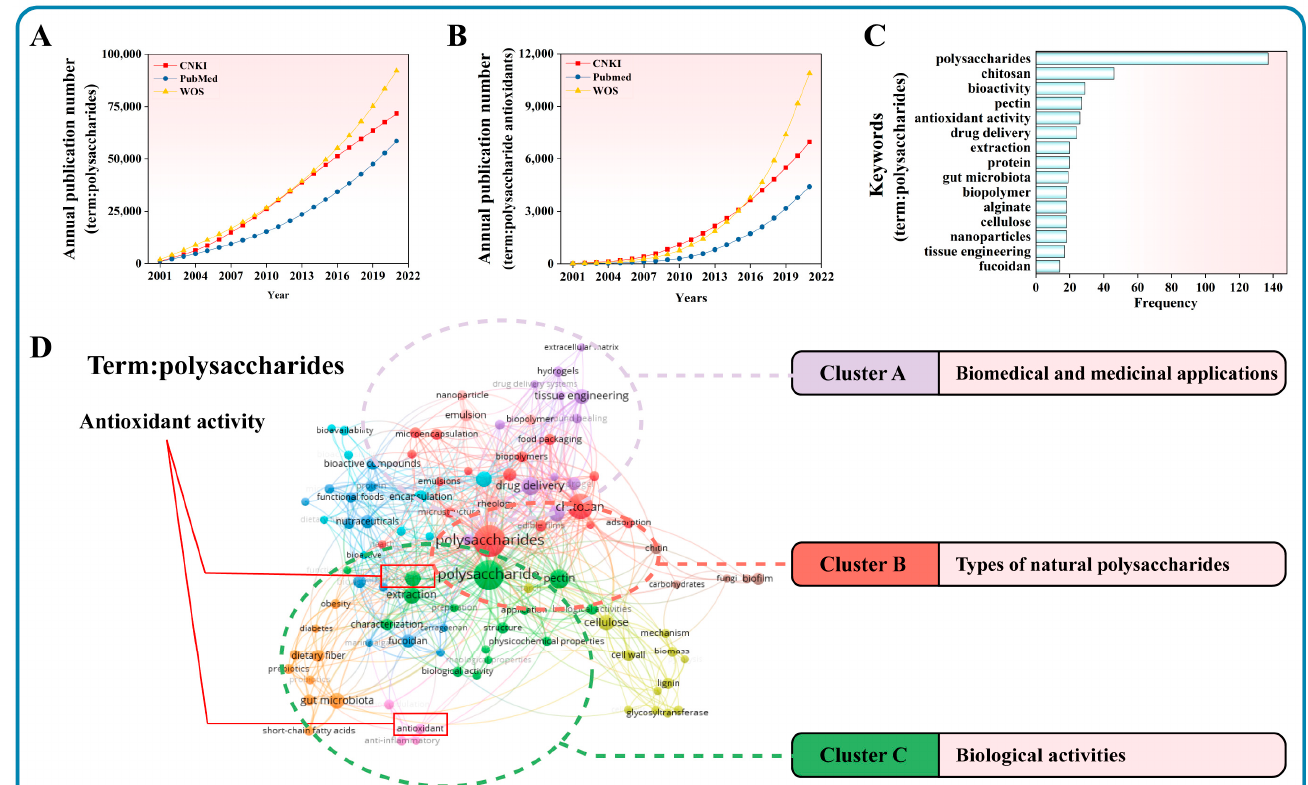
Figure 1. Scientometric analysis of polysaccharides. ( A ) Search results with polysaccharides as the topic word; ( B ) Search results with polysaccharides and antioxidant. ( C ) Frequency of keywords. ( D ) Keywords co-occurrence network. Node size and color represent the number of keywords and clusters. Lines of different colors represent different clusters.